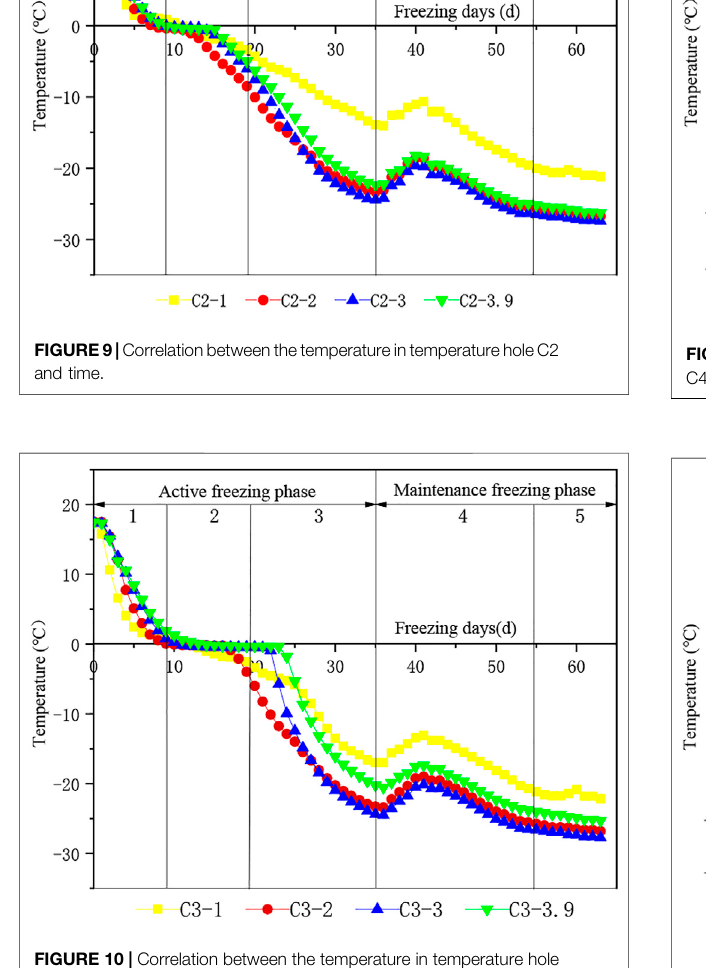
FIGURE 12 | Correlation between the temperature in temperature hole C5 and